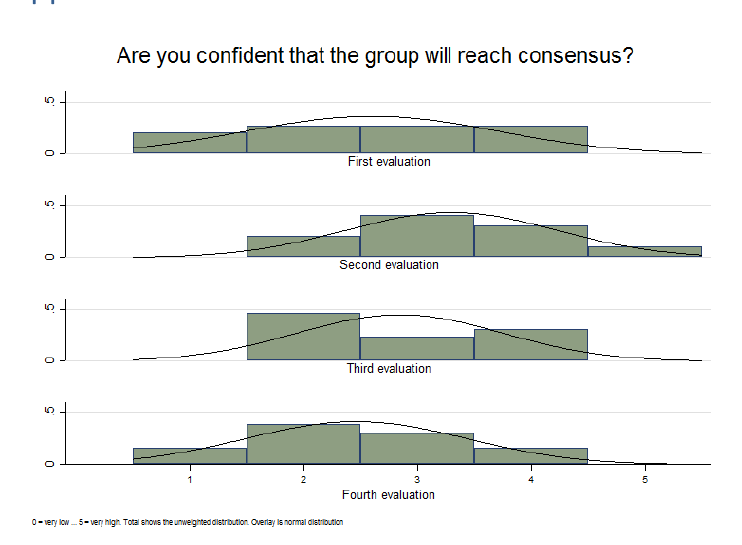
Figure A1.1 Results from the TANK process over time, “Confidence in reaching consensus”